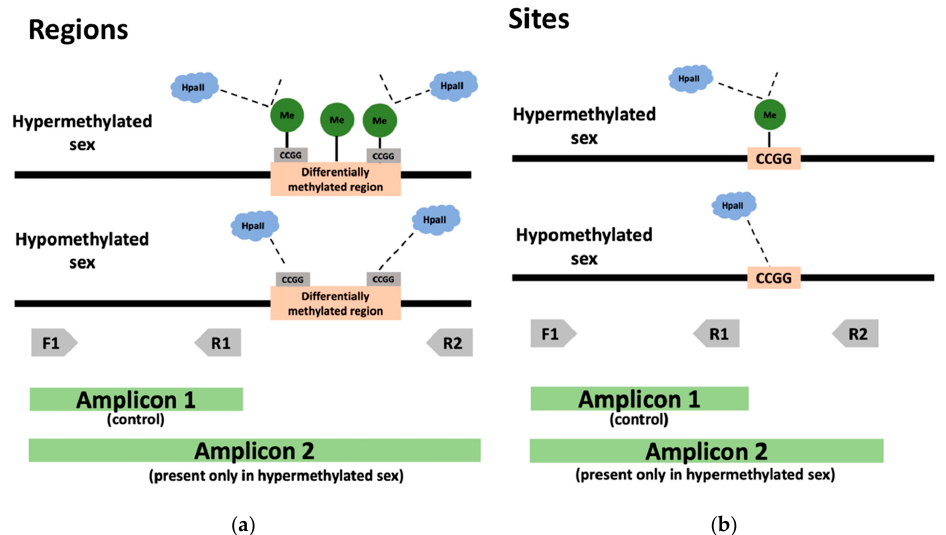
Figure 1. Methylation-sensitive PCR to validate the candidate regions and sites for tail sexing. In regions ( a ), the hypermethylated sex has one or more restriction cleavage sites for the methylation- sensitive restriction enzyme HpaII (CCGG) surrounded by methyl groups. In candidate sites ( b ), a single differentially methylated cytosine is located within the restriction cleavage site. In both these cases (regions and sites), methylation within the restriction sequence prevents DNA digestion by HpaII, while hypomethylation at this site permits DNA digestion. Primers F1 and R1 produce an amplicon irrespective of DNA methylation at the candidate region or site, and thus serve as a control, whereas amplicon 2 is only produced by primers F1 and R2 in the presence of methylation at the restriction site (when DNA digestion is prevented).